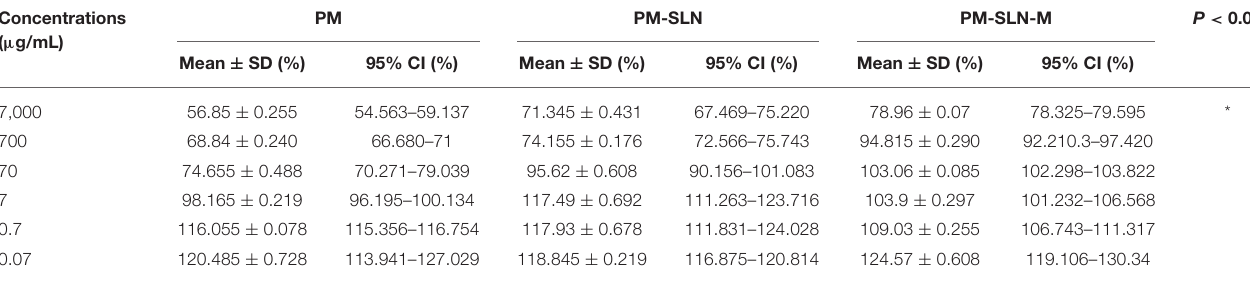
TABLE 2 | Vero cell viability against different concentrations of PM, PM-SLN, and PM-SLN-M. Concentrations ( µ